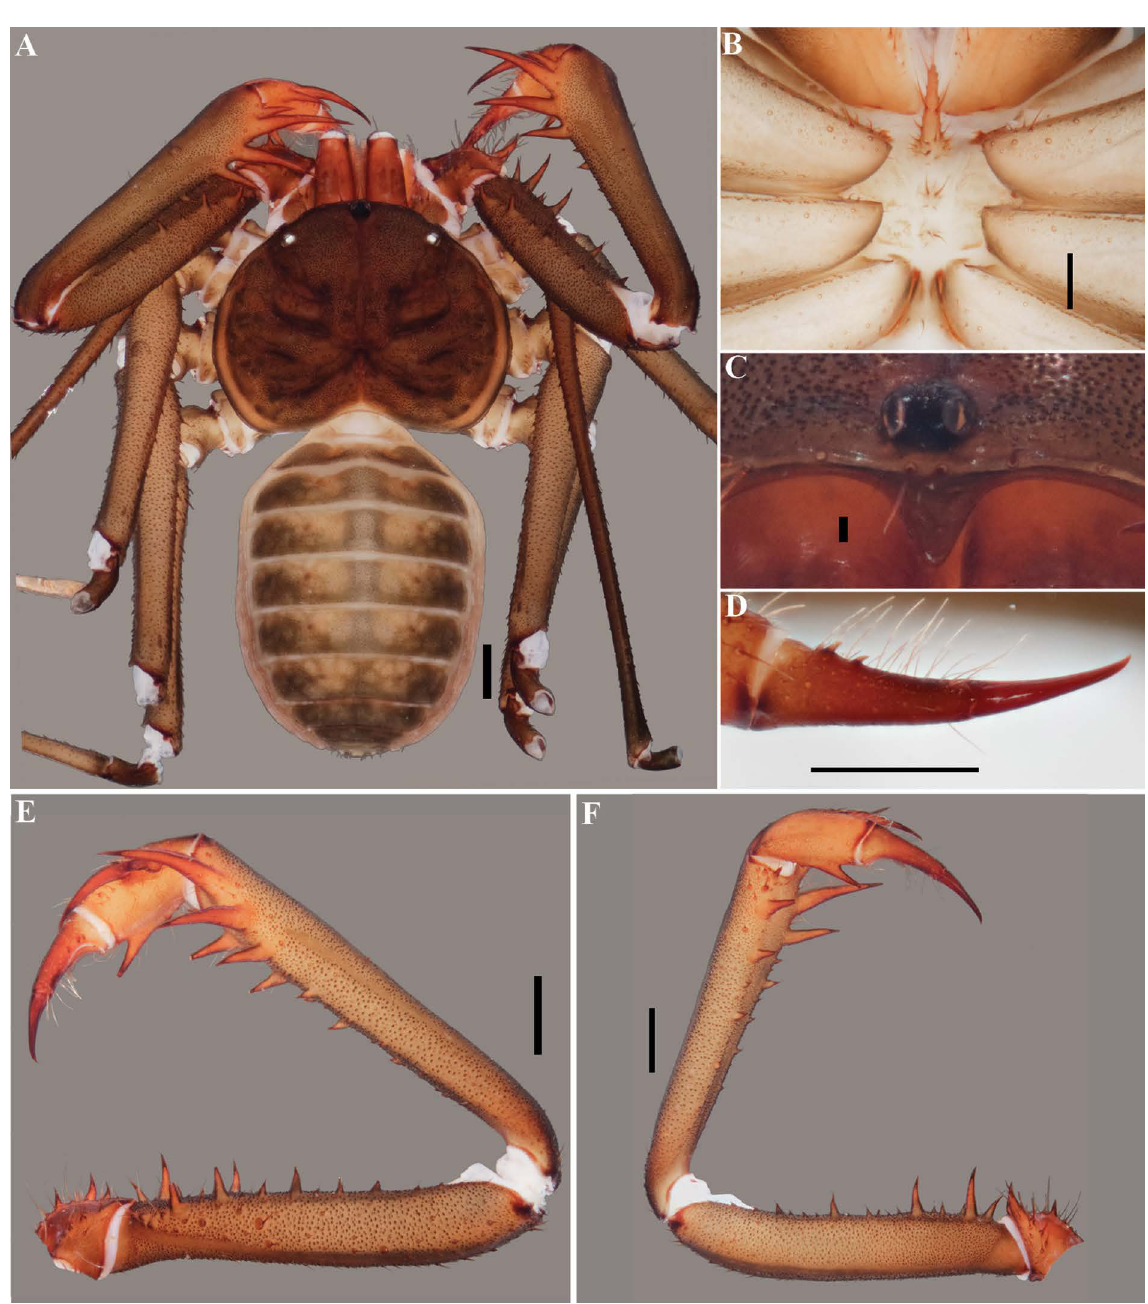
Fig. 131. Sarax yayukae Rahmadi, Harvey & Kojima, 2010 (AMCC [LP 12109]), general morphology, ♂. A . Habitus, dorsal view. B . Sternum, ventral view. C . Frontal process. D . Pedipalp tarsus, frontal view. E . Pedipalp, dorsal view. F . Pedipalp, ventral view. Scale bars: A–B, E–F = 1 mm; C = 0.1 mm; D = 1